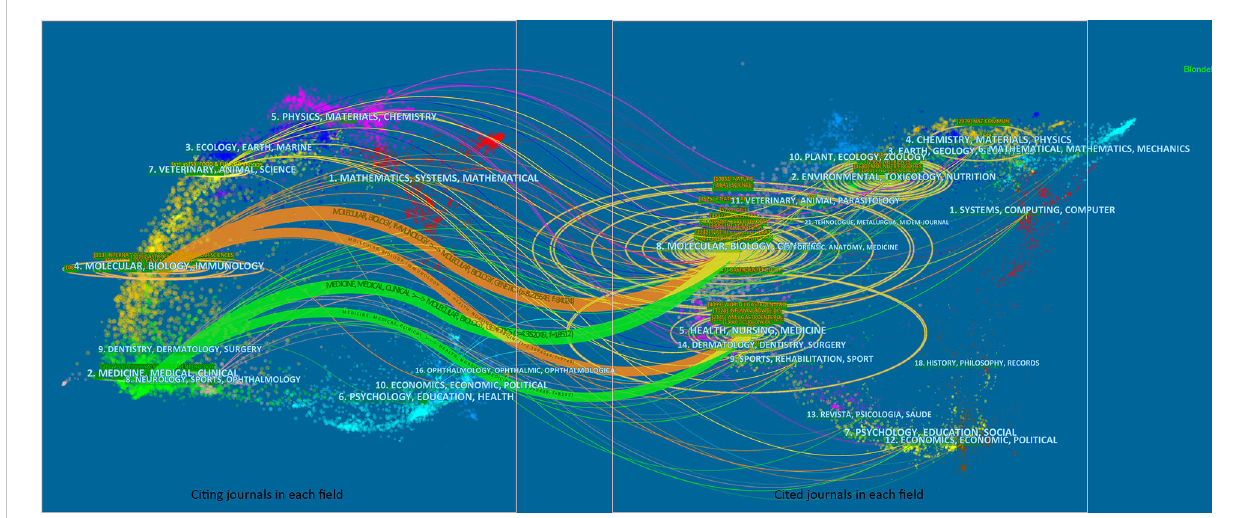
FIGURE 6 Dual-map citation portfolio analysis with thematic overlays. The publications and cited results were visualized. Wider edges a indicated higher value in occurrence. The left part of the plot indicated citing journals, and the right part of the plot indicated cited